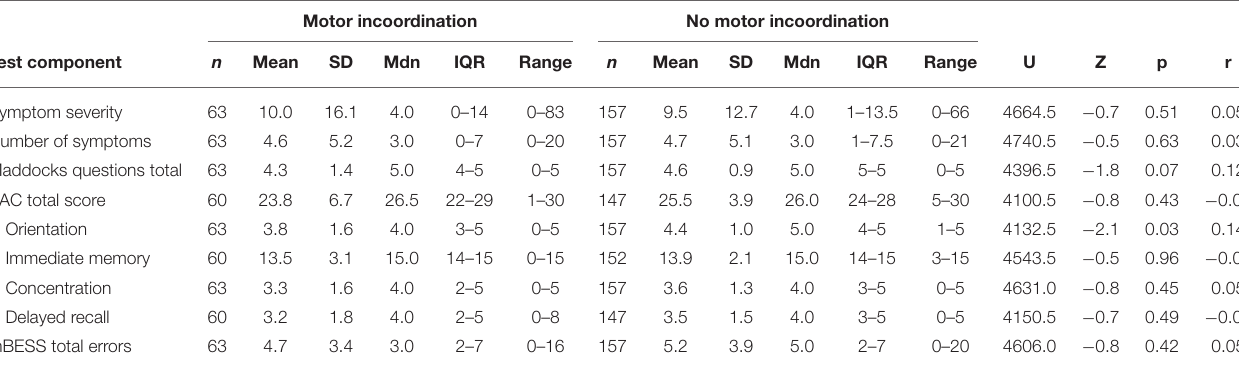
TABLE 2 | Concussed athletes’ SCAT5 component scores by presence vs. absence of motor